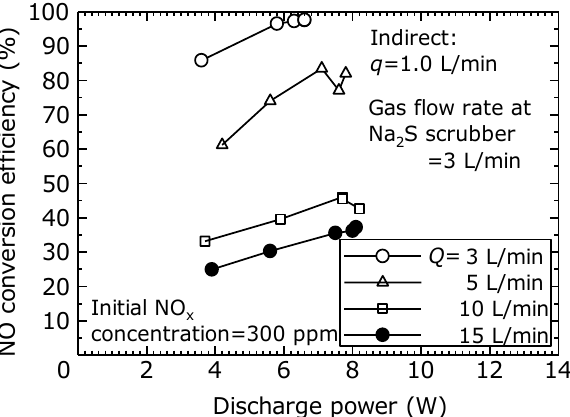
Figure 9. NO conversion efficiency varying with the discharge power at different flow rate by the indirect oxidation method.